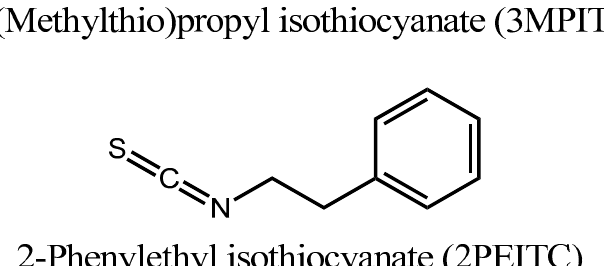
Figure 2. Chemical structures of isothiocyanates found in Bagrada bugs, Bagrada hilaris.